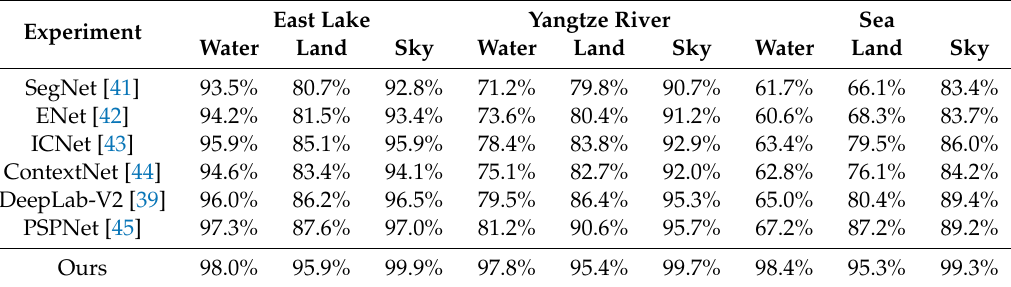
Table 3. Comparative experimental